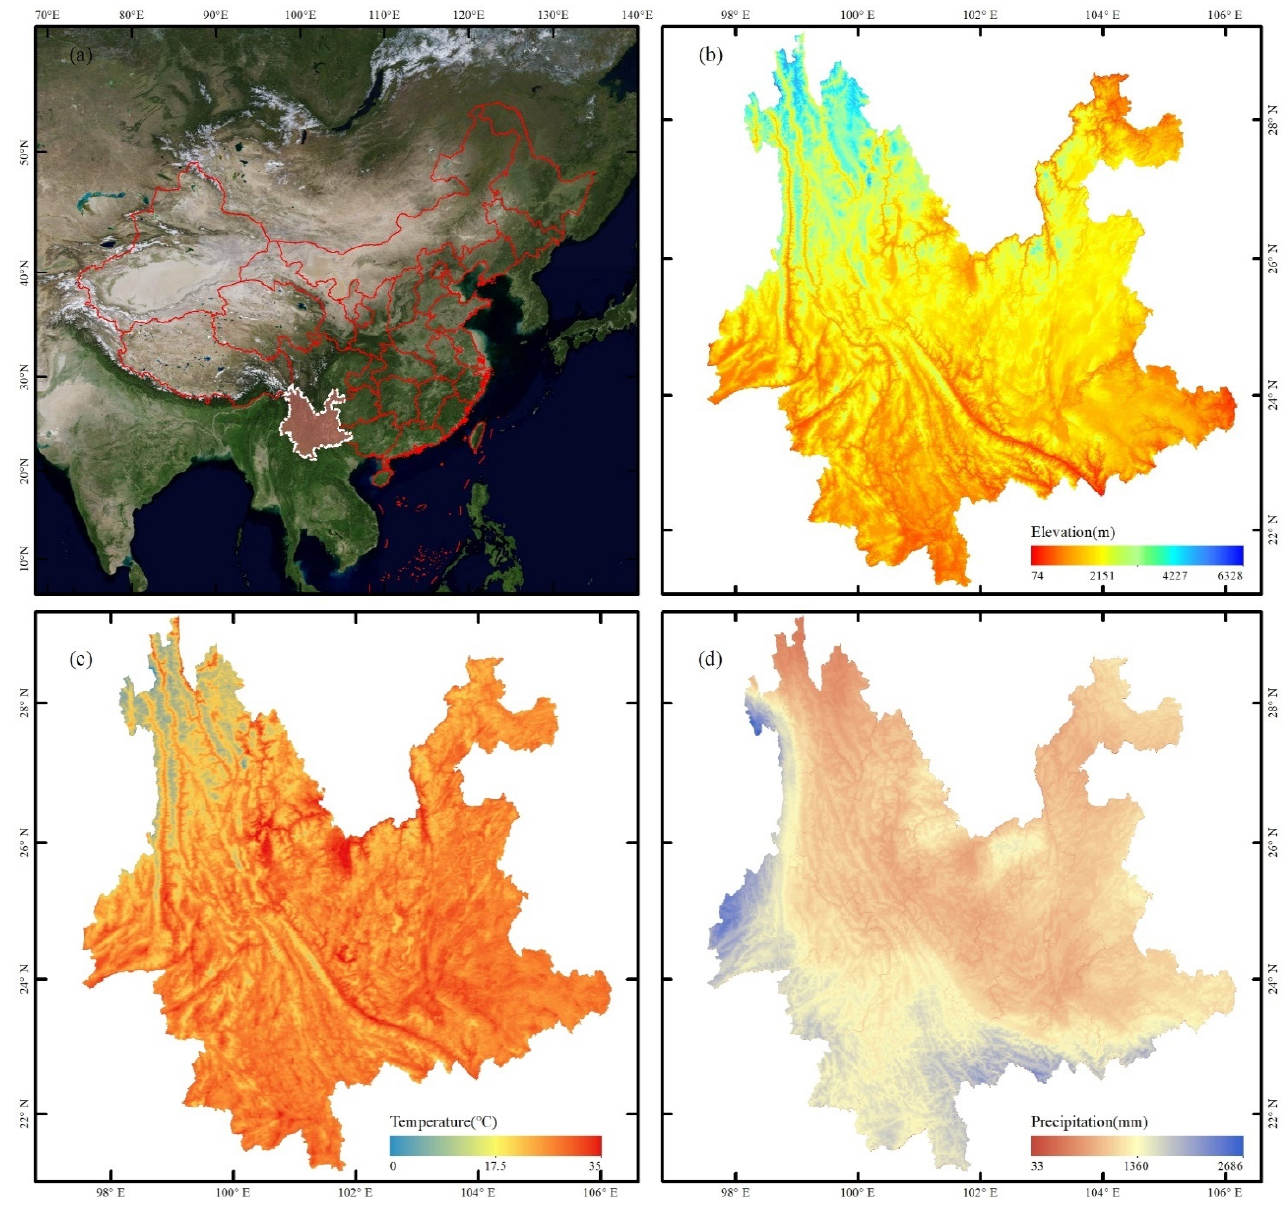
Figure 1. The geography of the study area. ( a ) the location; ( b ) the elevation; ( c ) the annual average temperature (MOD11A2 V6 product [34]); and ( d ) the annual total precipitation (OpenLandMap Precipitation monthly product [35] ).